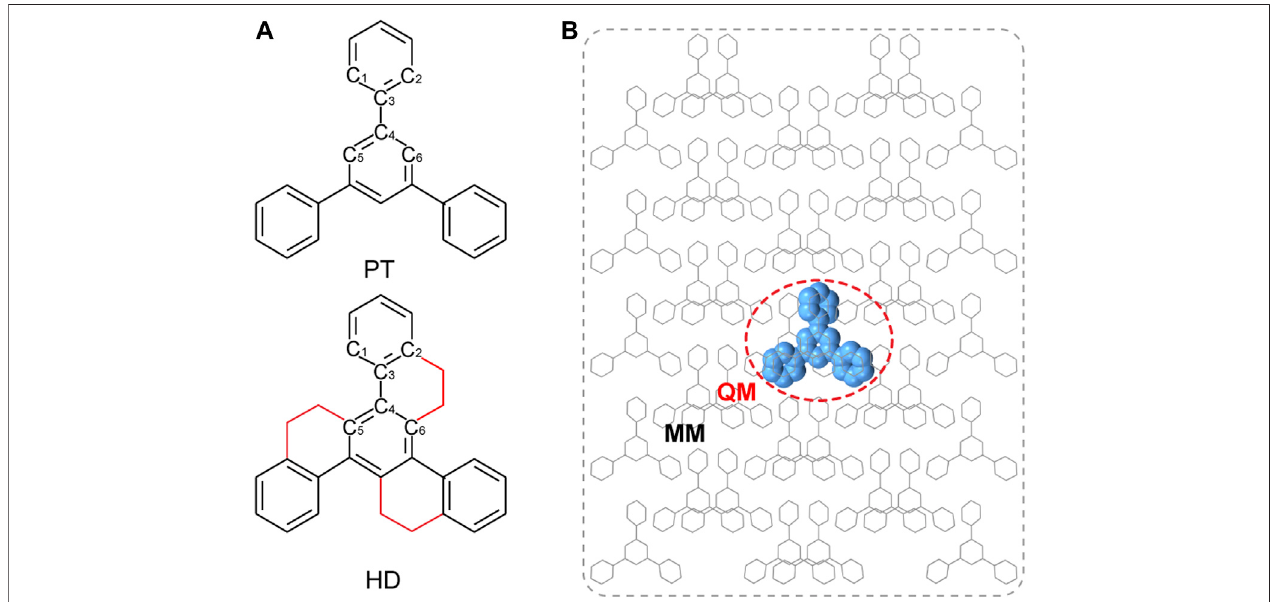
FIGURE 1 | (A) Chemical structure of PT and HD; (B) Setup of QM/MM models by taking PT as an